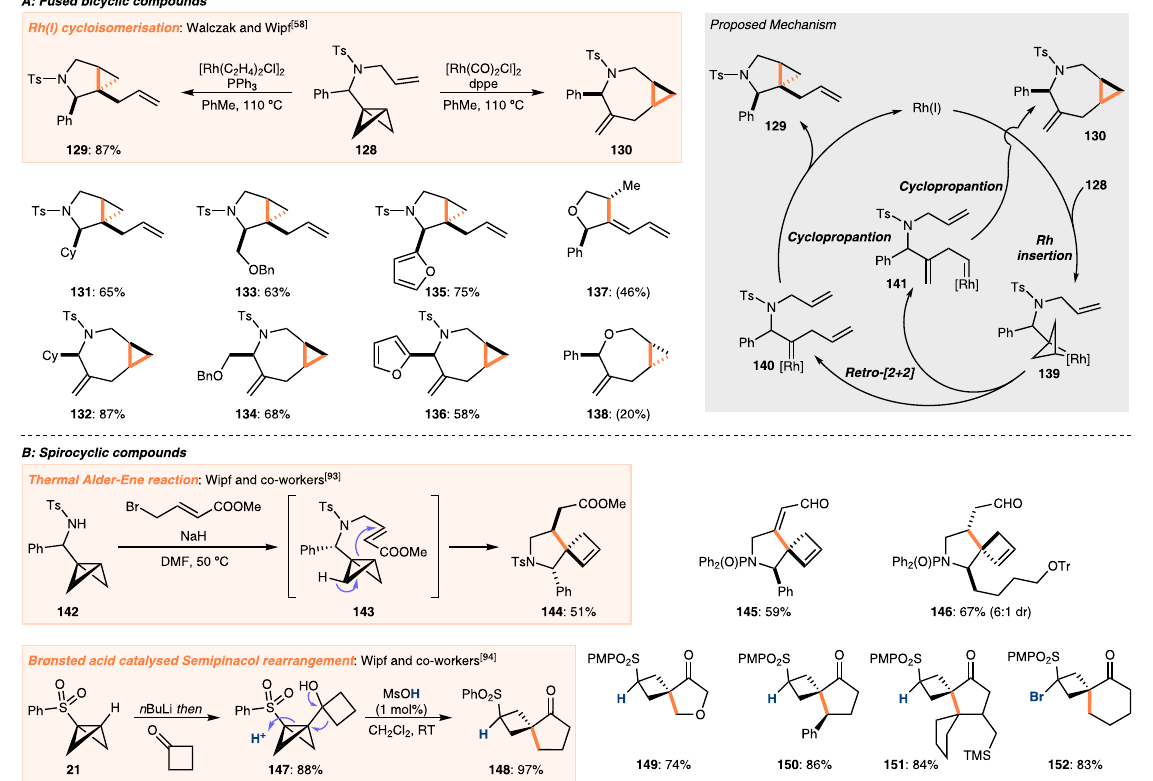
Fig. 6 Rearrangement reactions of BCBs to give fused and spirocyclic compounds. A Divergent Rh(I)-catalysed cycloisomerisation reactions of bicyclobutanes to give fused bicyclic structures. The selectivity of the reaction can be controlled by the choice of ligand and the initial step of the reaction involves the insertion of the rhodium into the bicyclobutane. B Reactions of bicyclobutanes that lead to spirocyclic compounds. Both a thermal Alder-Ene reaction and an acid-catalysed Semipinacol rearrangement are highlighted. Yields in brackets refer to yields determined by 1 H NMR. dppe 1,2- bis(diphenylphosphino)ethane, Ts toluene sulfonyl, Ms methane sulfonyl, PMP para